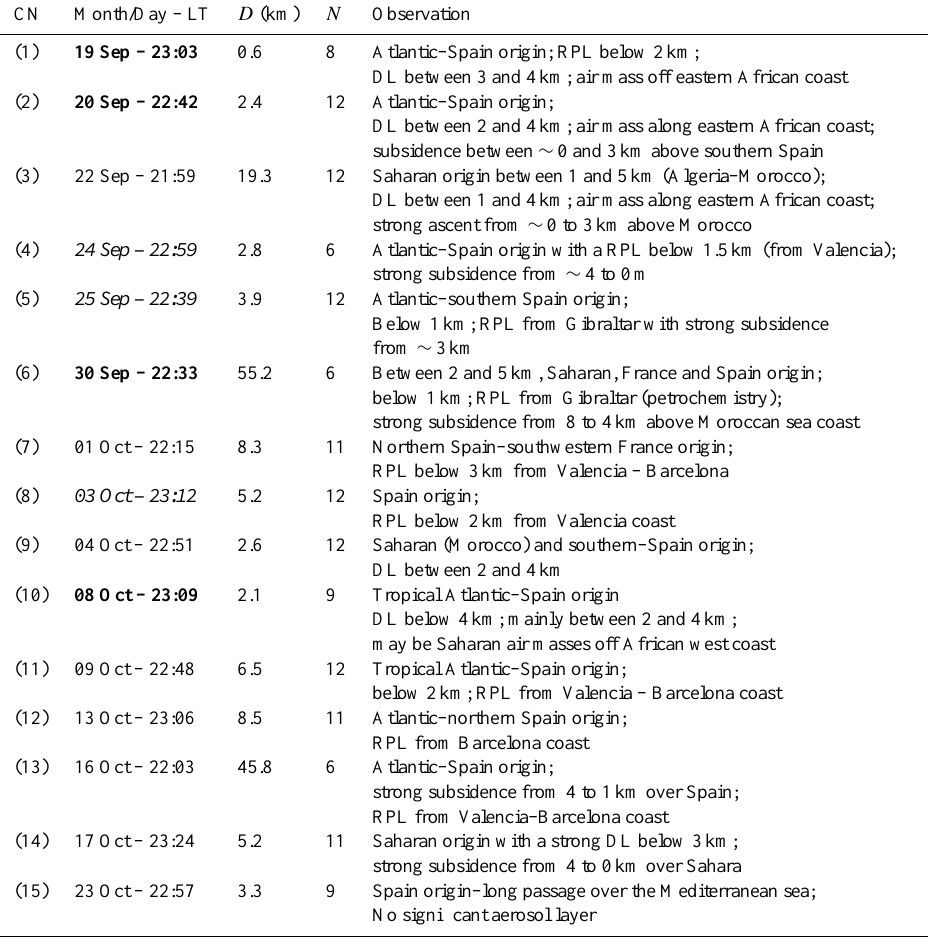
Table 2. List of the coincidence numbers (CN) and description of the associated aerosol layer synoptic origin during the HyMeX experiment (2012 fall period). D represents the distance between the ground-based lidar and the center of the 12 selected IASI pixels. N is the number of available averaged IASI profiles. The wettest (driest) coincidences are in bold (italic). The presences of dry layer (DL) and residual particle layer (RPL) are